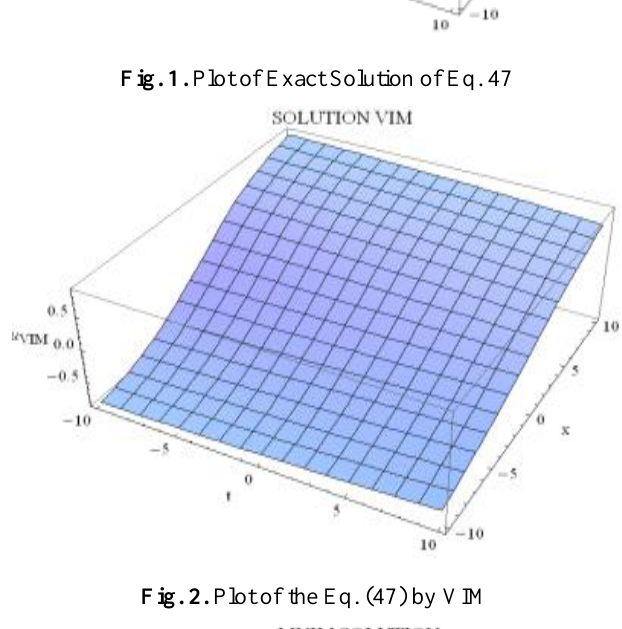
Fig. 2. Plot of the Eq. (47) by VIM